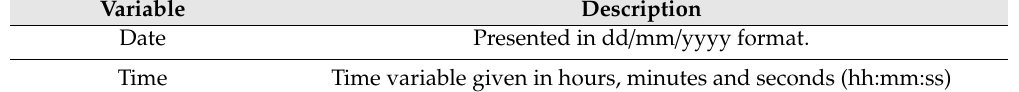
Table 2. Feature representation and detailed description of the residential dataset, namely the “individual household electricity consumption dataset”. Variable Description Date Presented in dd / mm / yyyy format. Time Time variable given in hours, minutes and seconds (hh:mm:ss) Global active power Minutely given average active and reactive power for individual house. Global active power Voltage One-minute average voltage Intensity Current intensity for every minute. Active electricity related to kitchen, laundry room and living room of Submetering (1, 2, 3) residential home, while only one submetering_1 sensor in commercial dataset is related to o ffi ce